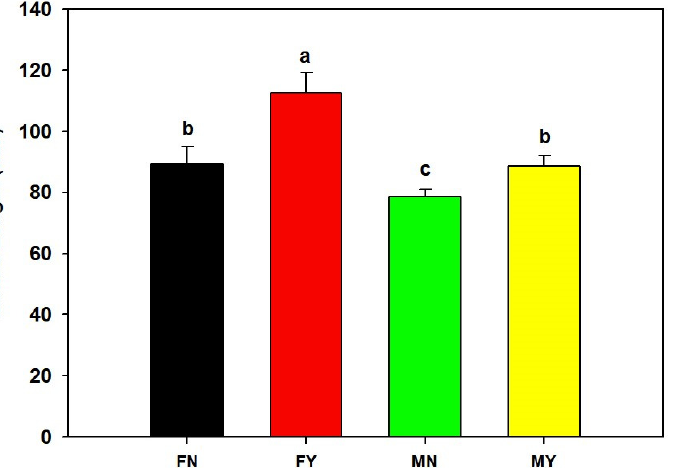
Figure 1. Mantle lengths of dwarf-form populations of Sthenoteuthis oualaniensis. Significant differences are indicated by different letters ( p < 0.05).